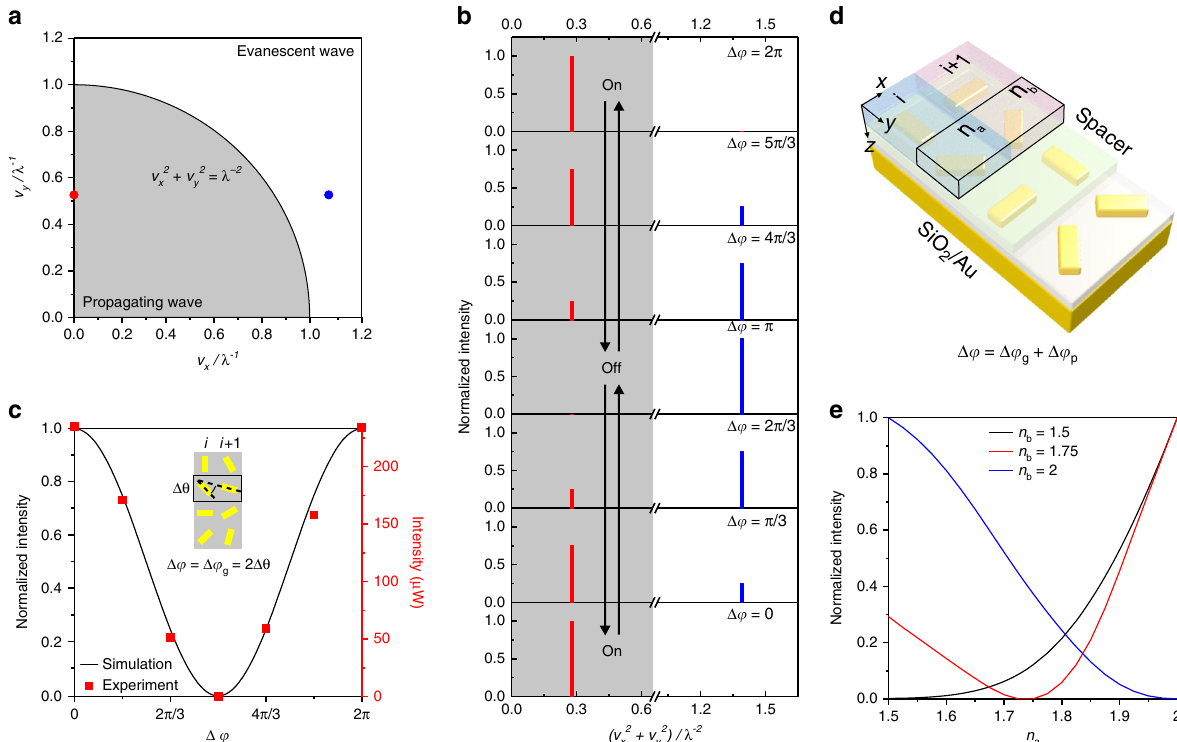
Fig. 2 Mechanism of dynamic spatial frequency modulation. a Two-dimensional spatial frequency spectrum calculated from the discrete phase distribution pro fi le de fi ned in Eq. (1). The spacing between the optical elements in the neighboring rows and columns are both taken as 300 nm and the operating wavelength is 633 nm. The circle of v 2 x þ v 2 y ¼ λ (cid:3) 2 separates the zones of output propagating (gray) and evanescent (white) waves. Red and blue dots correspond to the low and high frequency components, respectively. b Calculated intensities of the low and high spatial frequency components in dependence on Δ φ . The zones of the propagating and evanescent waves are indicated in gray and white, respectively. c Experimental and simulated results of the anomalous re fl ection intensity modulated by Δ φ . Δ θ de fi nes the angle difference between the gold nanrods located in the neighboring odd and even columns, respectively. Each gold nanorod has a dimension of 200 nm × 80 nm × 30 nm. They reside on a gold mirror spaced by a SiO 2 layer (100 nm). d Schematic of the re fl ective metasurface, in which the gold nanorods are embedded in a spacer with a refractive index of 1.5 and thickness of 50 nm. The alternating columns are further covered by two dielectric materials with refractive indices of n a and n b , respectively. Δ φ contains contributions from both geometric ( Δ φ g ) and propagation phases ( Δ φ p ), i.e., Δ φ = Δ φ g + Δ φ p . e Simulated intensity of the anomalously re fl ected light in dependence on n a and n b